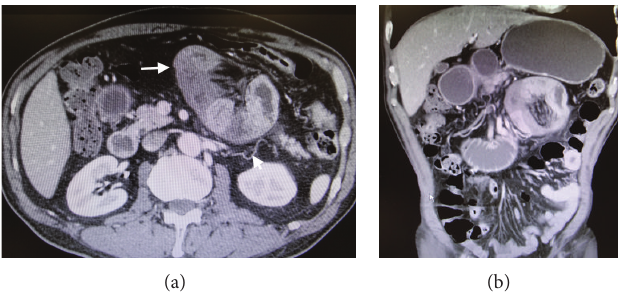
Figure 2: An axial computed tomography scan shows an encapsulated cluster of dilated small bowel loops (arrow) occupying the upper quadrant. A small bowel loop is ascending the left colic artery (arrowhead).